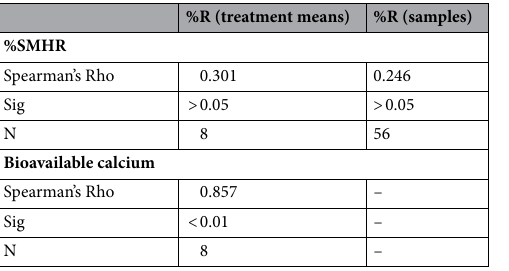
Table 5. Correlations between %R and %SMHR, and between %R and bioavailable